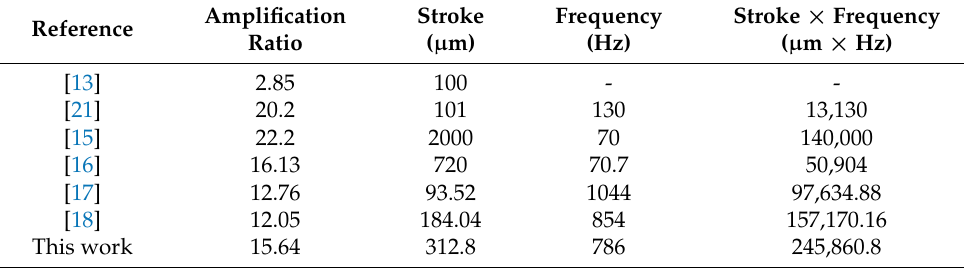
Table 2. Performance comparison of typical